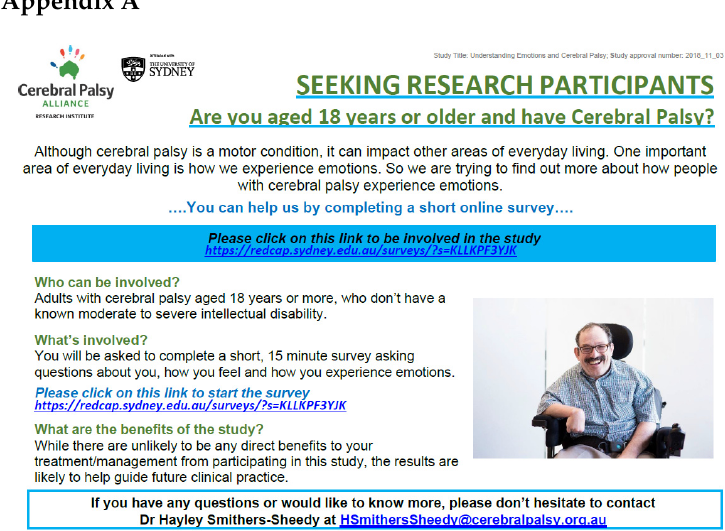
Figure A1. Study invitation fl yer.